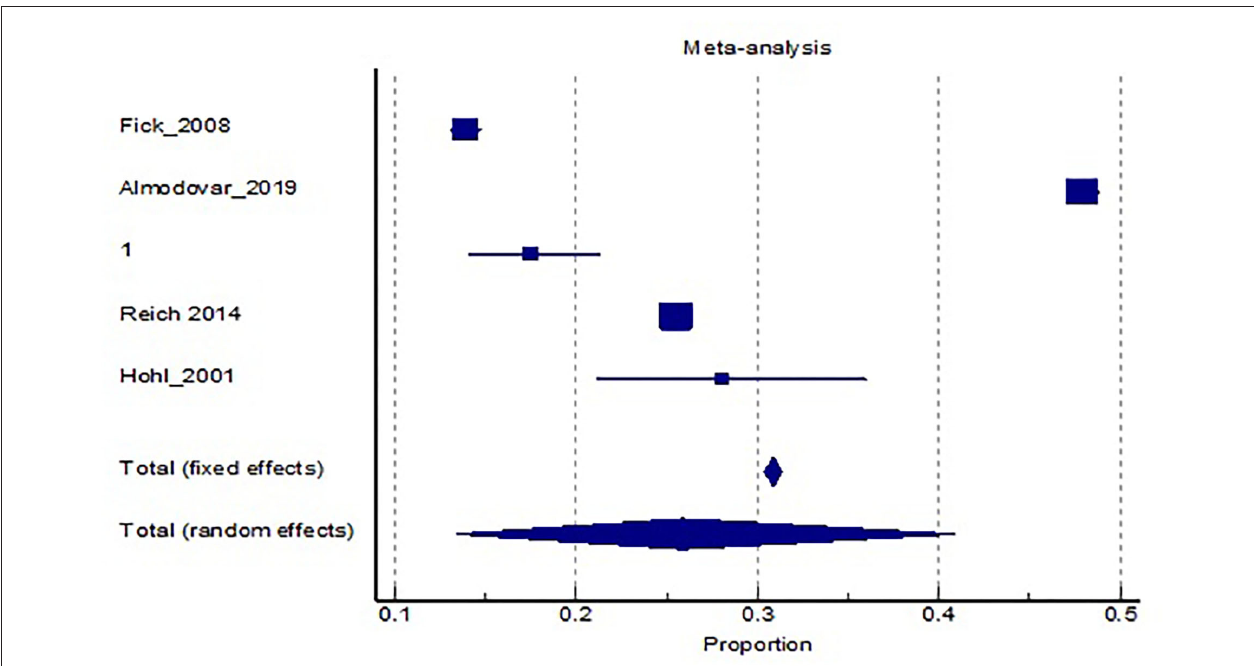
FIGURE 3 | Meta-analysis and distribution of results regarding the risk of developing a DRP with a PIM